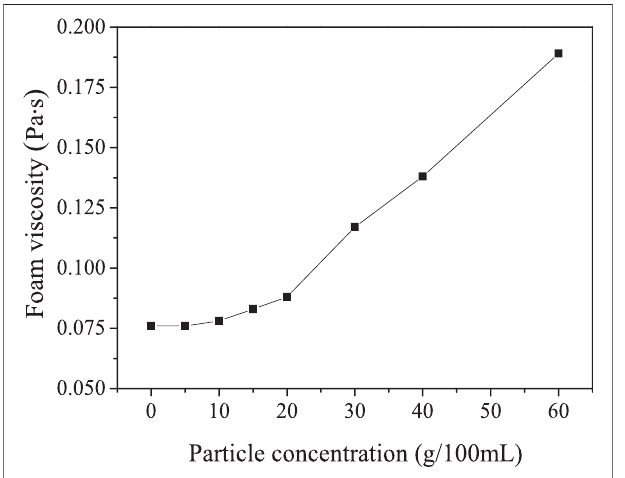
FIGURE 3 | Effect of particle concentration on foam viscosity.